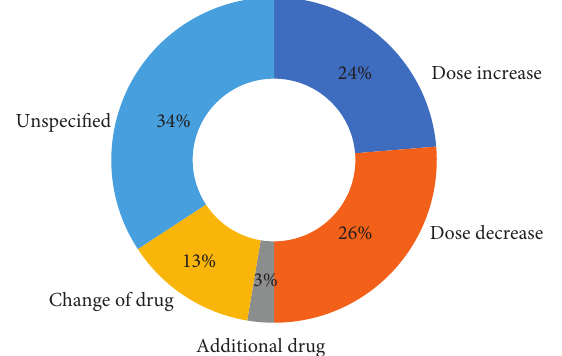
Figure 2: Types of medication changes in Parkinson’s disease patients after discharge.